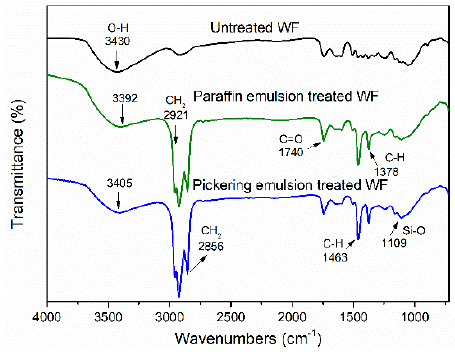
Figure 4. Fourier-transform infrared (FTIR) characterization of untreated and emulsion treated WFs.